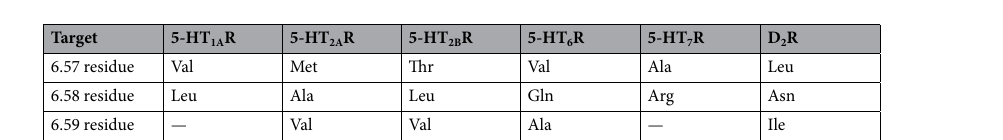
Table 3. Amino acid residue at 6.57, 6.58 and 6.59 positions in relevant